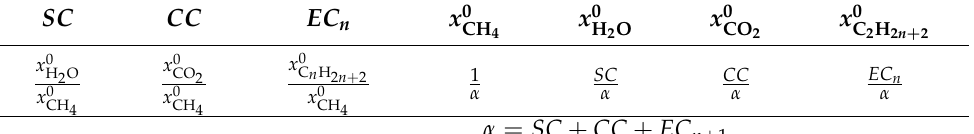
Figure 3. Boundaries of carbon deposition ( a ) carbon deposition regime for different carbohydrates fuels ( b ) carbon formation regime for model associated petroleum gas. Table 3. Boundary conditions: relation between initial mol fraction and parameters SC , NC , EC n , CC